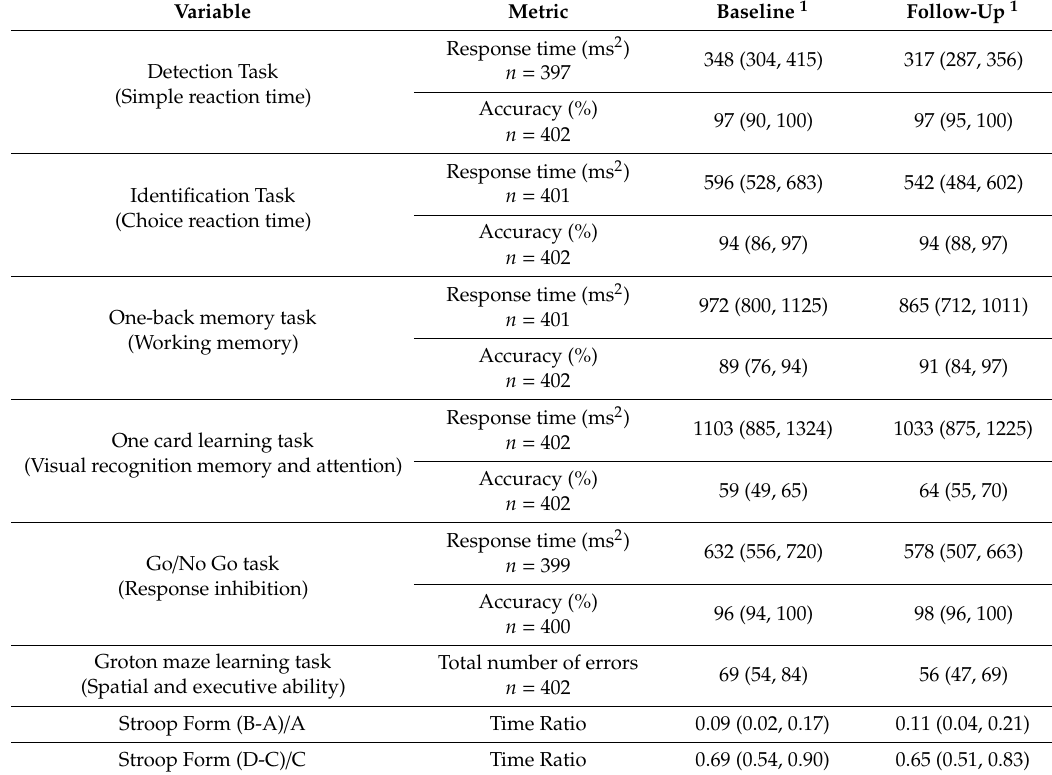
Table 2. Descriptive statistics for cognitive function outcomes as assessed by CogHealth and Stroop color-word test time